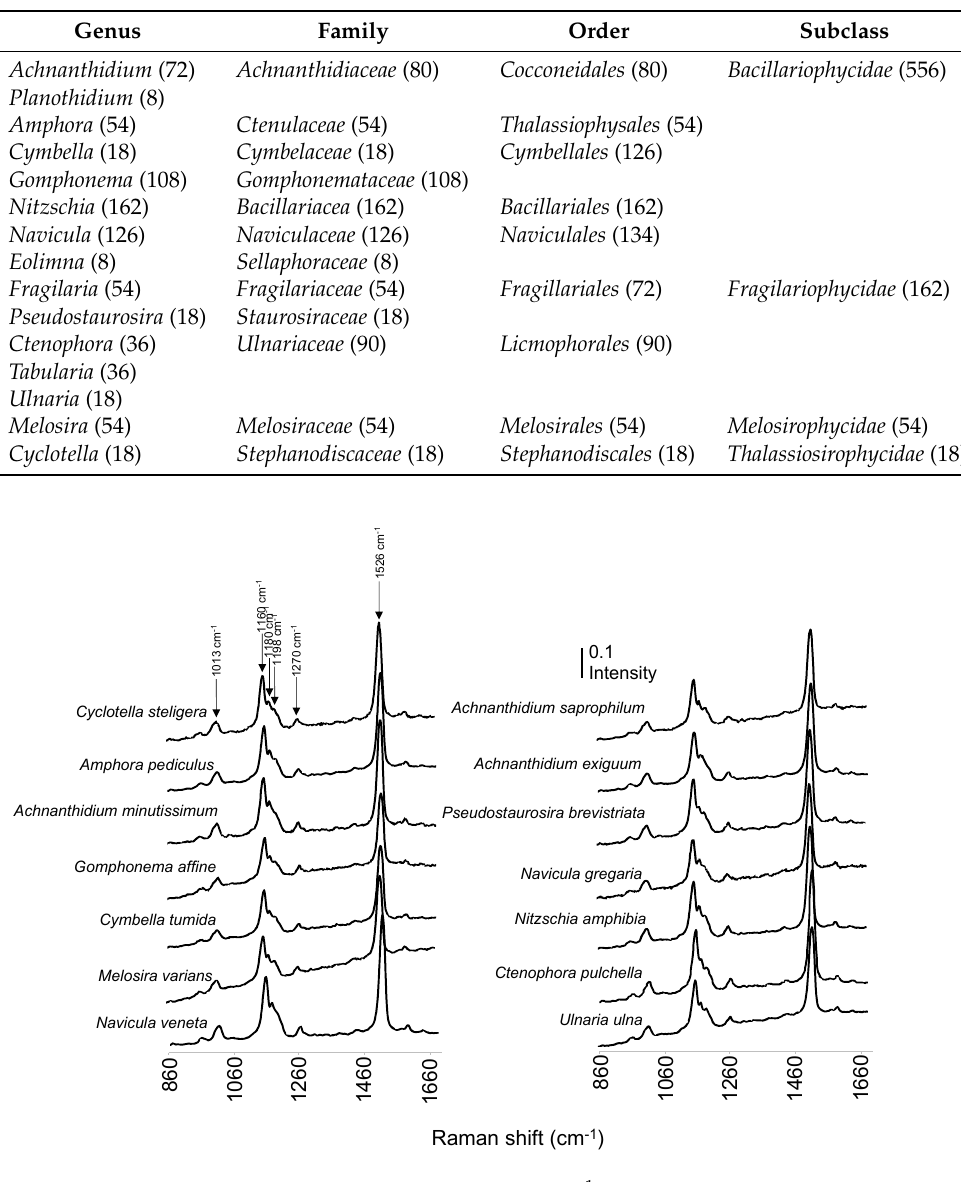
Table 1. Number of Raman spectra collected from each diatom taxonomic level. In total 790 Raman spectra were acquired.